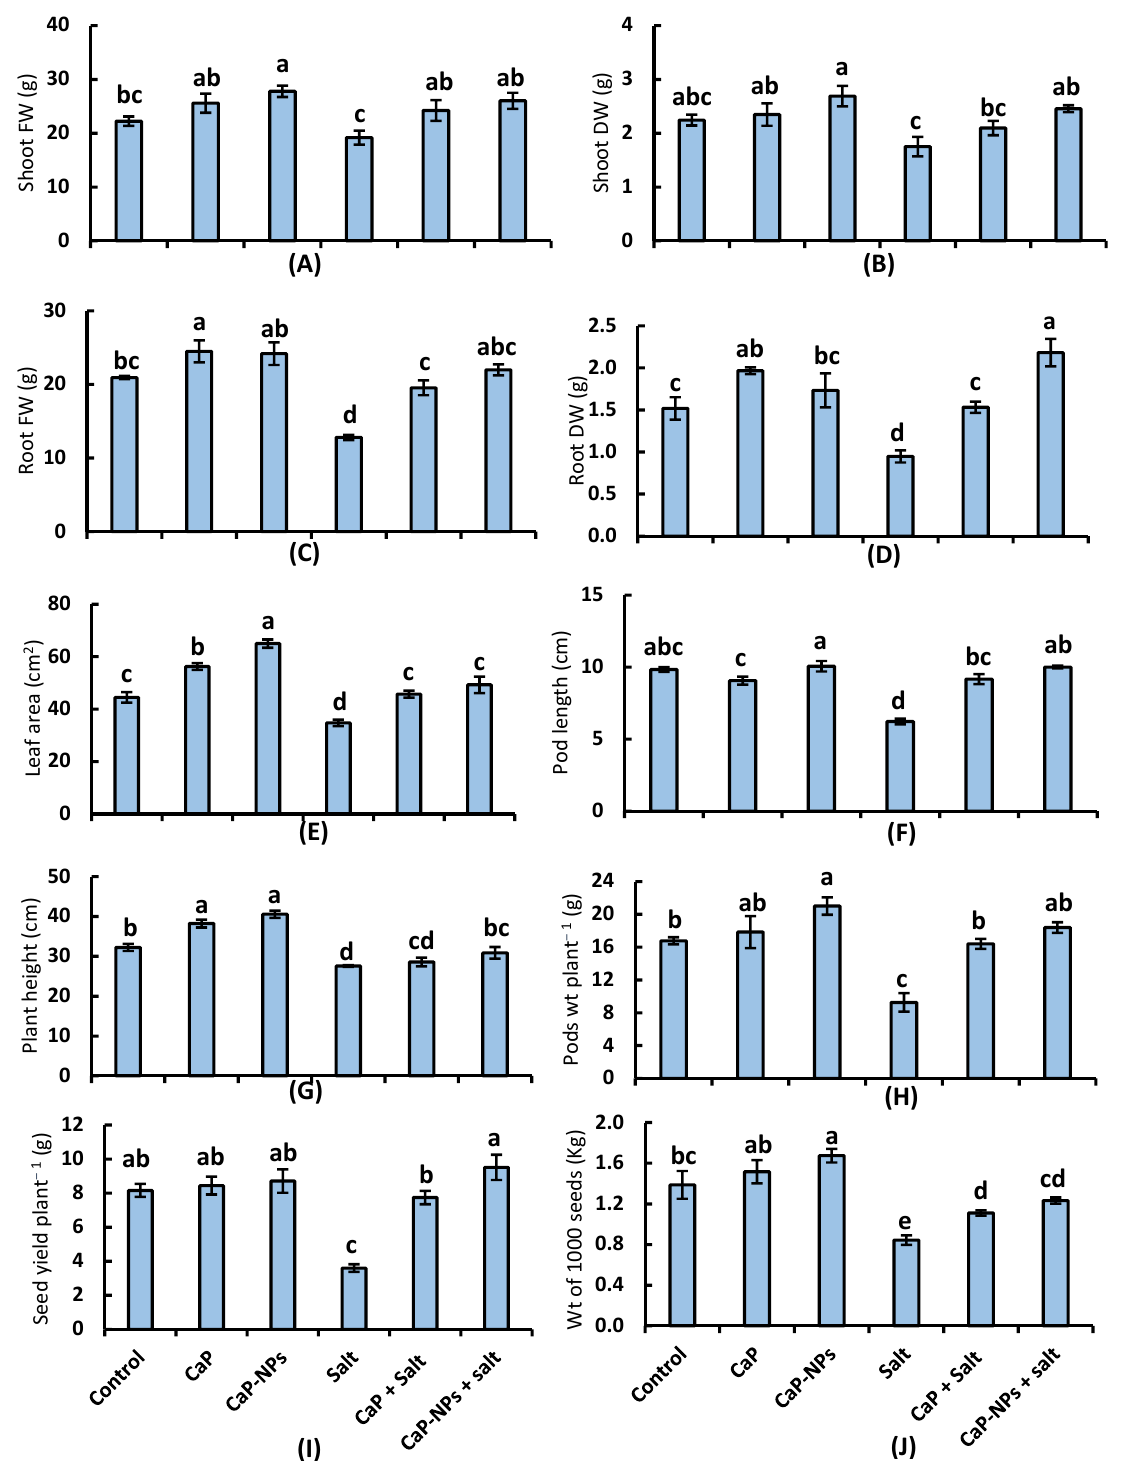
Figure 3. Effect of different treatments on ( A ) shoot fresh weight, ( B ) shoot dry weight, ( C ) root fresh weight, ( D ) root dry weight, ( E ) leaf area, ( F ) pod length, ( G ) plant height, ( H ) pods weight/plant, ( I ) seed yield/plant, and ( J ) weight of 1000 seeds. The same letters indicate no significant difference ( p < 0.05) as analyzed by the Duncan test. Each value is the average of 3 replicates ± SE.